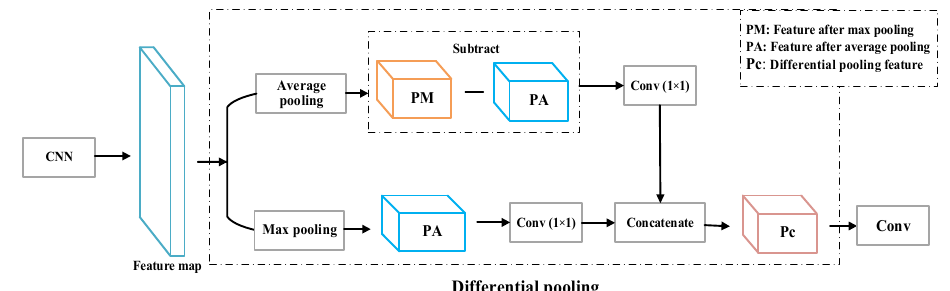
Figure 8. Differential pooling